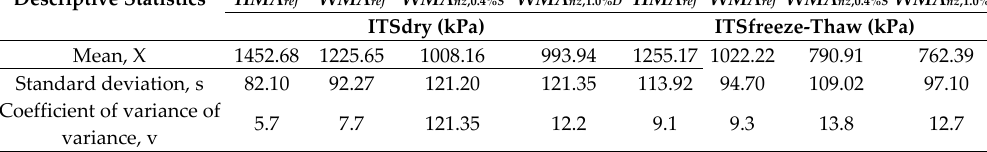
Figure 11. Results of indirect tensile strength ( ITS dry and ITS freeze ‐ thaw ) determination in Marshall samples produced from the investigated AC 16; error bars represent ±1 standard deviation from the mean.